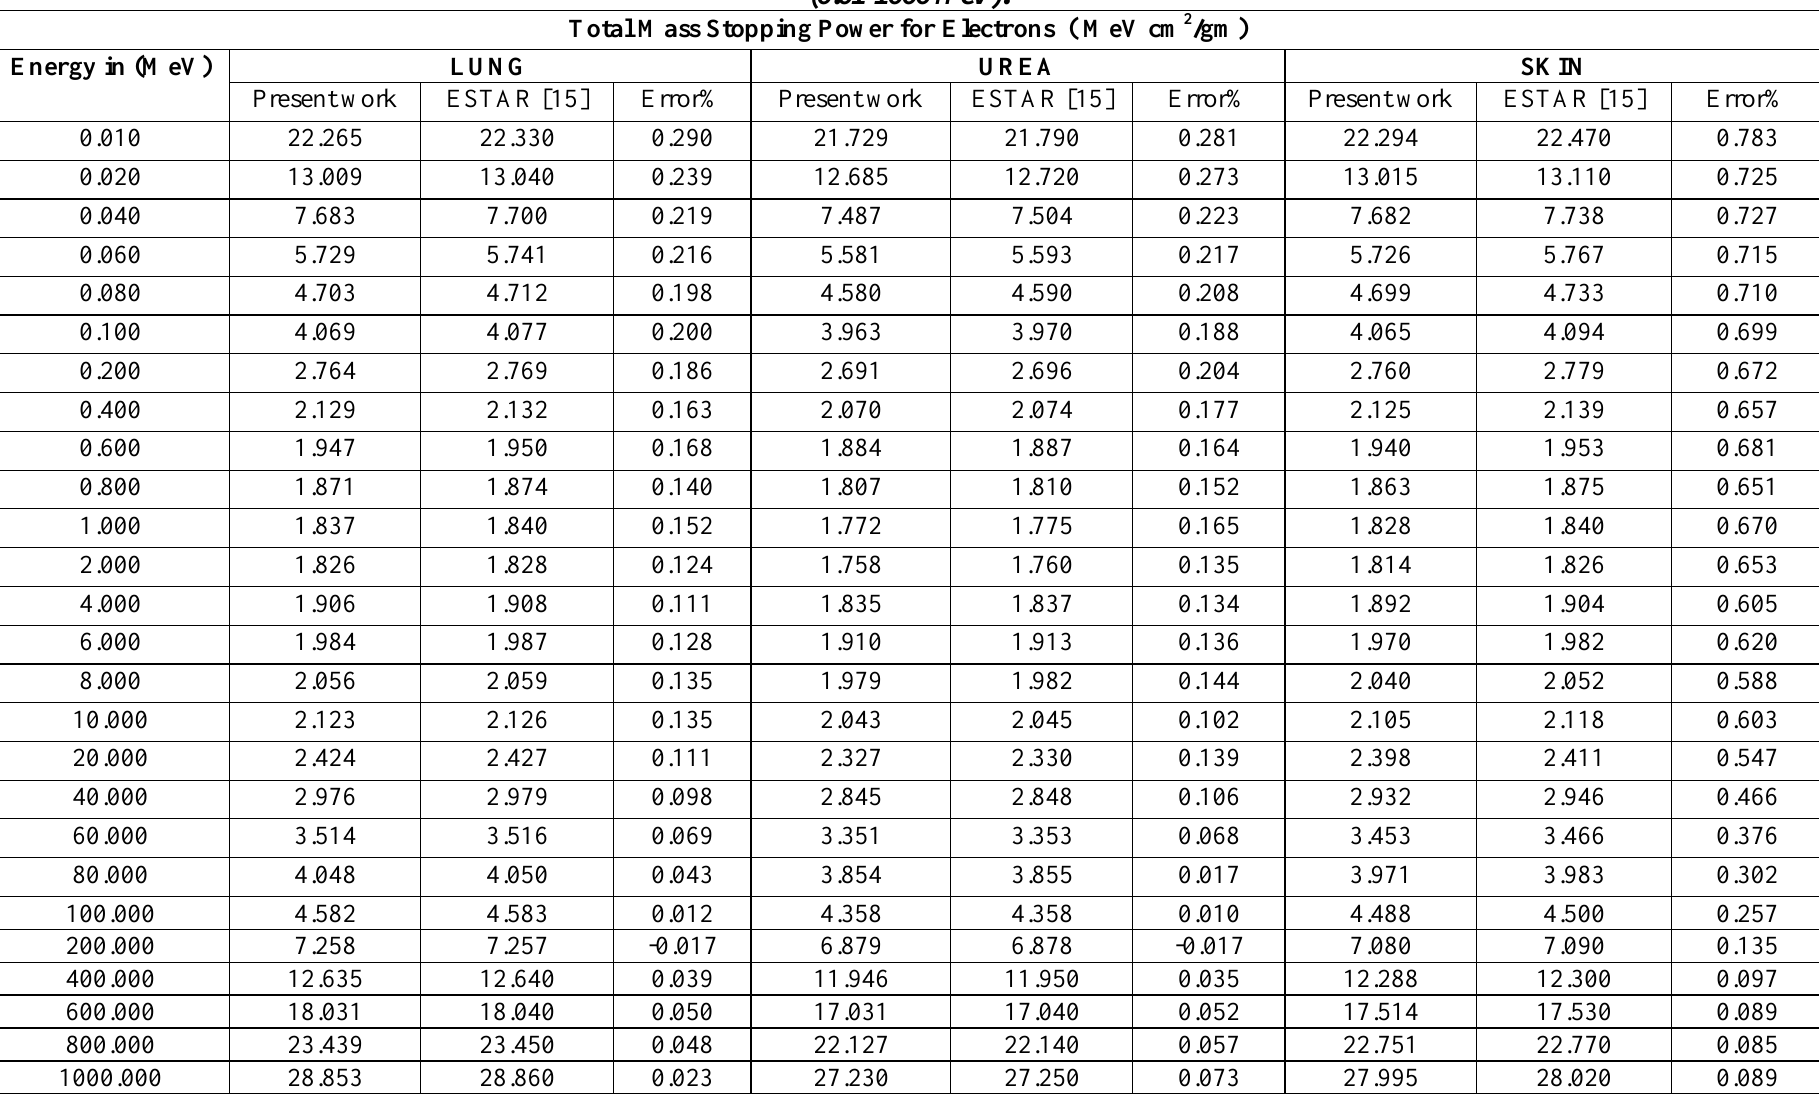
Table 3: Comparison of the present results of the total mass stopping power for electrons in Lung, Urea and Skin with the standard published data in the energy range (0.01-1000